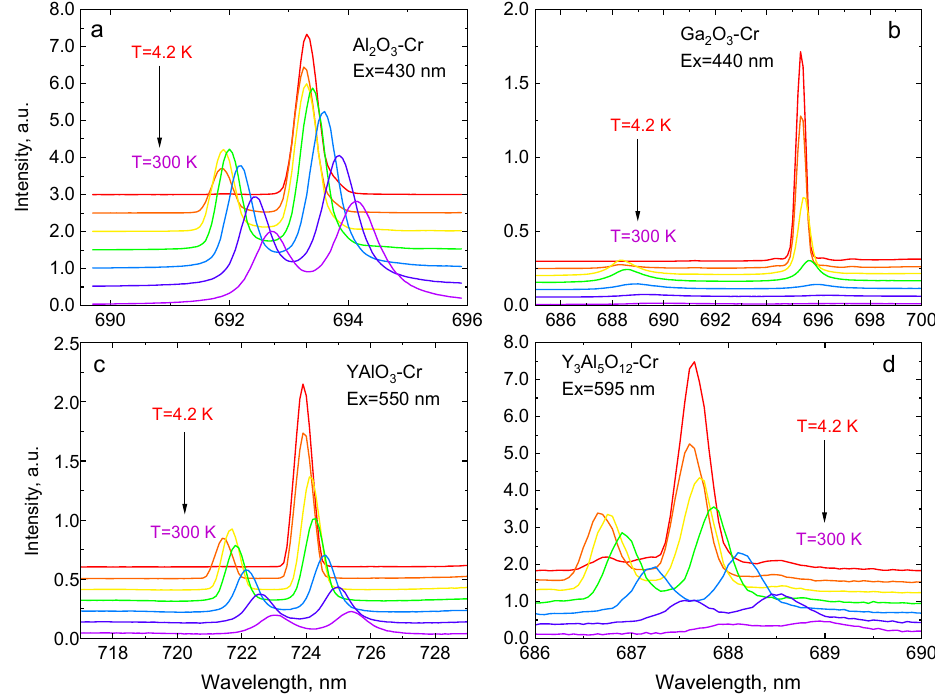
Figure 4. Variation of the luminescence spectra in the region of R-lines with temperature, measured in Cr-doped Al 2 O 3 ( a ), Ga 2 O 3 ( b ), YAlO 3 ( c ), and Y 3 Al 5 O 12 crystals ( d ). Temperature increment in the plots is 50 K.